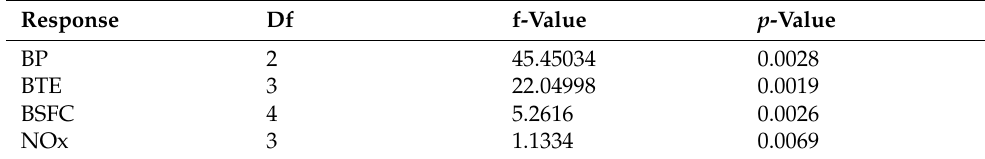
Table 5. ANOVA test results of regression models.